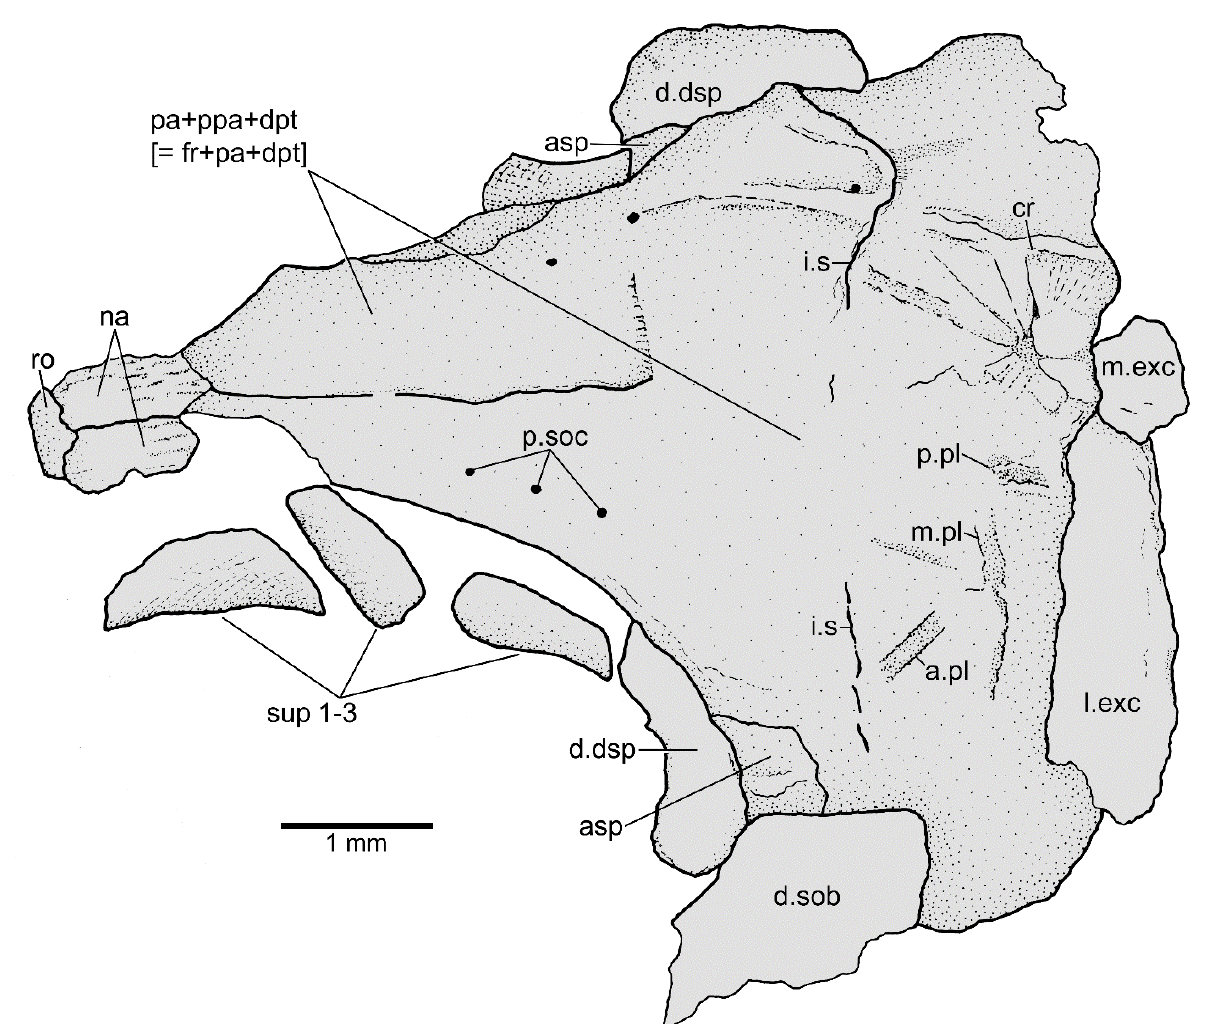
Figure 3. Seinstedtia parva gen. et sp. nov. Skull roof of paratype MLU Sei.2010.83 in dorso-lateral view. Abbreviations: a.pl, anterior pitline; asp, autosphenotic; cr, crest; d.dsp, displaced dermosphenotic; d.sob, displaced suborbital; i.s, incomplete suture; l.exc, lateral extrascapula; m.exc, median extrascapula; m.pl, middle pitline; na, nasal bone; pa + ppa + dpt [=fr + pa + dpt], parietal + postparietal + dermopterotic [=frontal + parietal + dermopterotic]; p.pl, posterior pitline; ro, rostral; sup1–3, supraorbitals